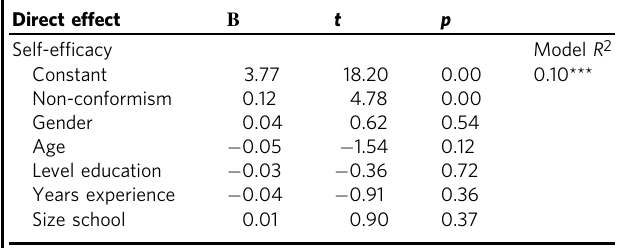
Table 2 Direct effect of non-conformism on self-ef fi